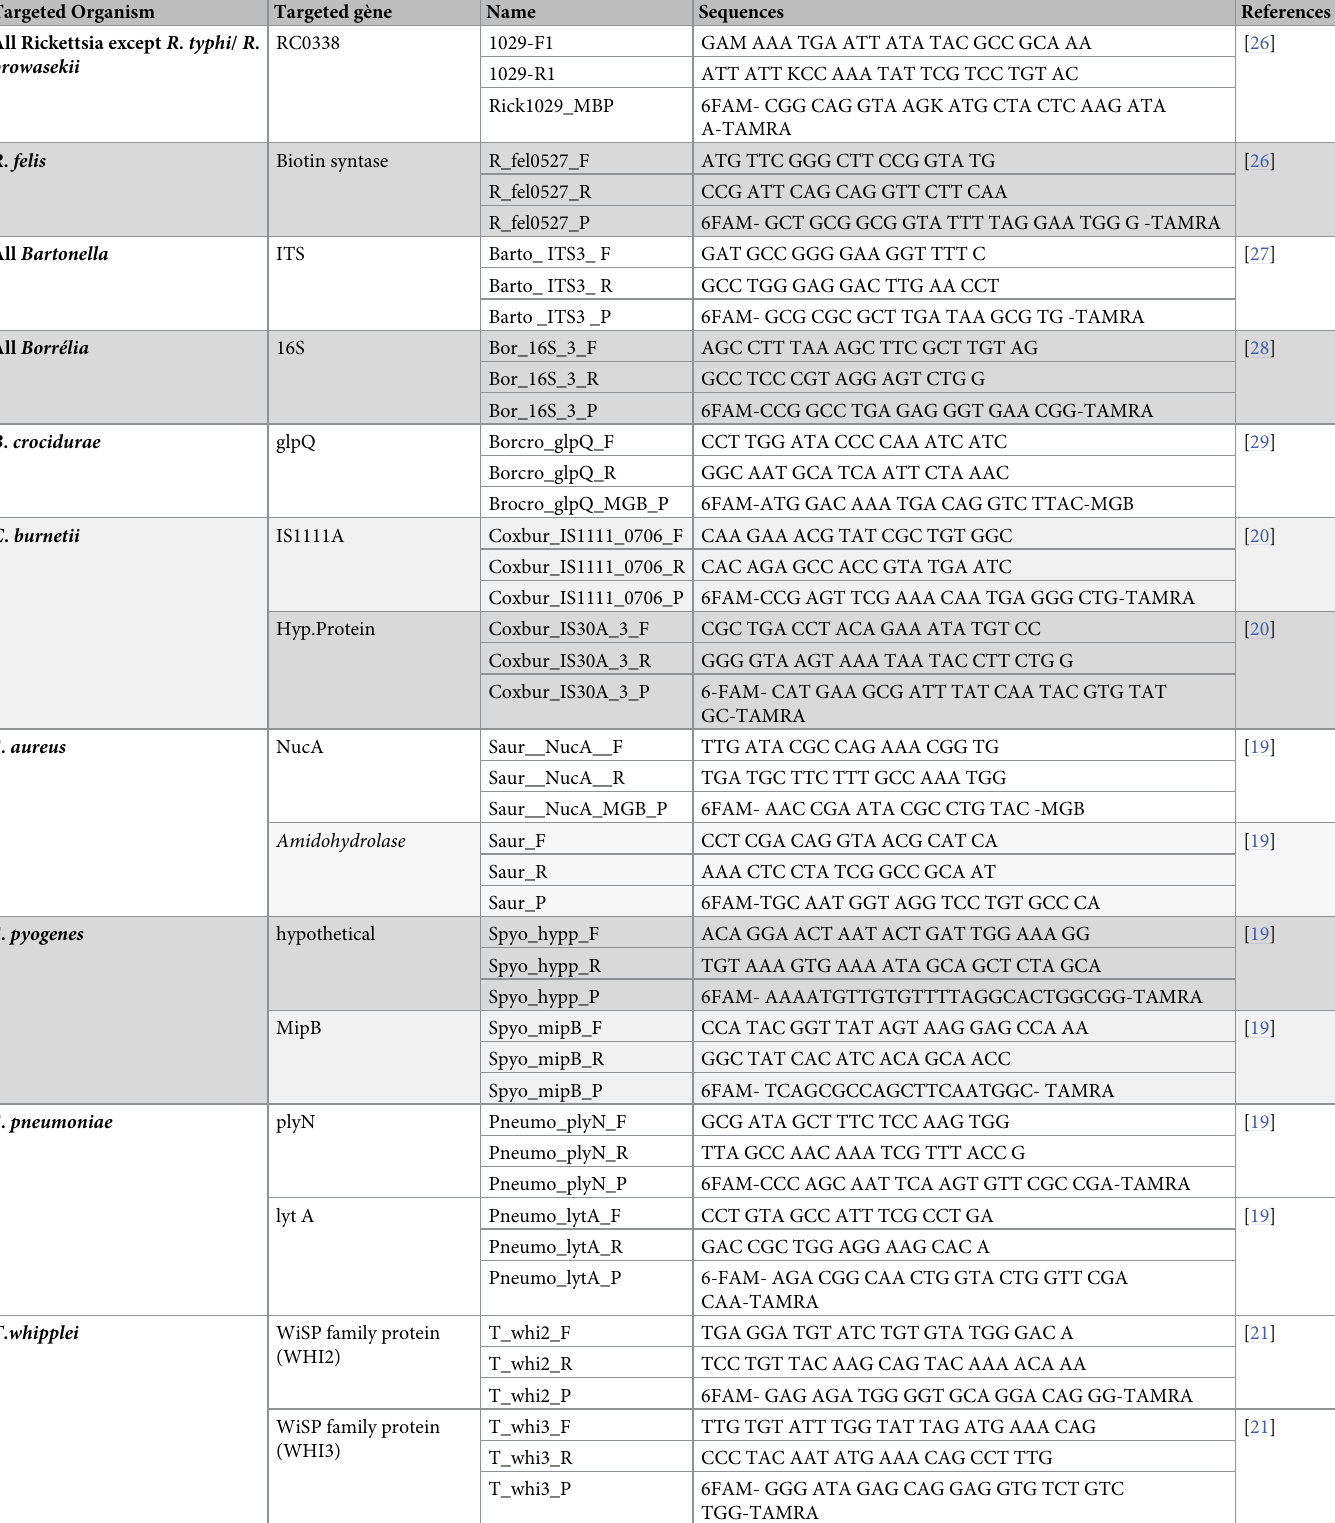
Table 1. Target sequences, primers and probes used in a